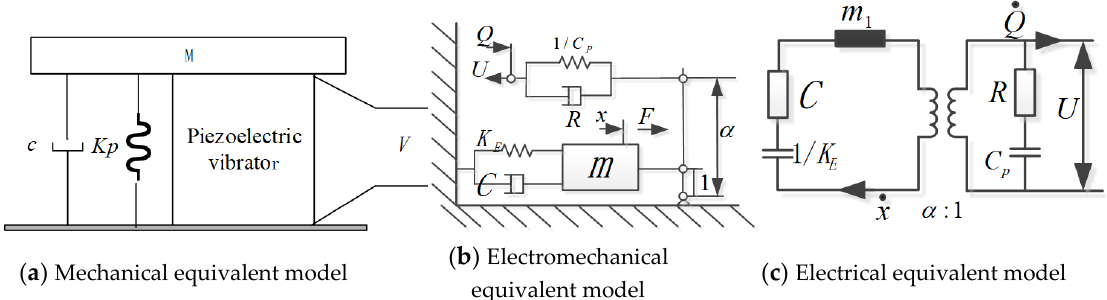
Figure 3. Equivalent model of the airflow-induced acoustic piezoelectric generator.